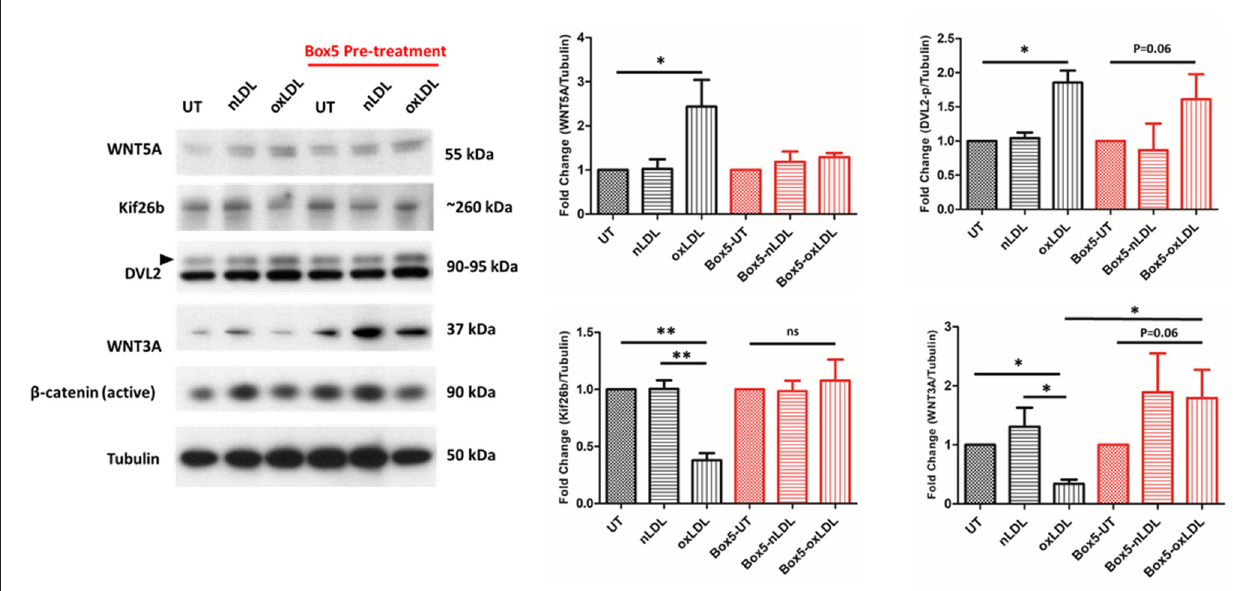
FIGURE 2 | Box5 Blocks rWNT5A and oxLDL Mediated Non-canonical Wnt Signaling in Human Vascular Smooth Muscle Cell Line. Representative western blots evaluating the expression of WNT signaling components in response to oxLDL. In response to oxLDL, there was a significant increase in WNT5A and DVL2 (black arrow) expression ( p < 0.05, p < 0.01; respectively). There was also a significant decrease in Kif26b expression ( p < 0.01), indicative of activation of non-canonical WNT signaling in oxLDL-treated VSMCs. There was a significant decrease in WNT3A expression ( p < 0.01), in the oxLDL treated group. An overall increasing trend in WNT3A and active β -catenin expression in the Box5 pre-treated groups was found. All protein experiments were performed in triplicate and western blot band intensities were quantified and are presented as bar graphs (mean ± SEM) of the ratio of control normalized (protein of interest)/tubulin protein. ns = not significant to untreated control (UT or UT-Box5); * = compared between groups ( p < 0.05); ** = compared between groups ( p < 0.01).